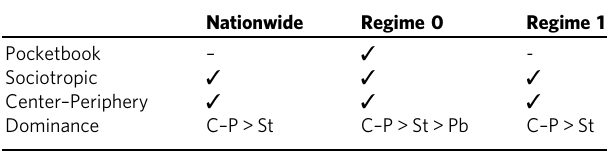
Table 5 Voting behavior by spatial